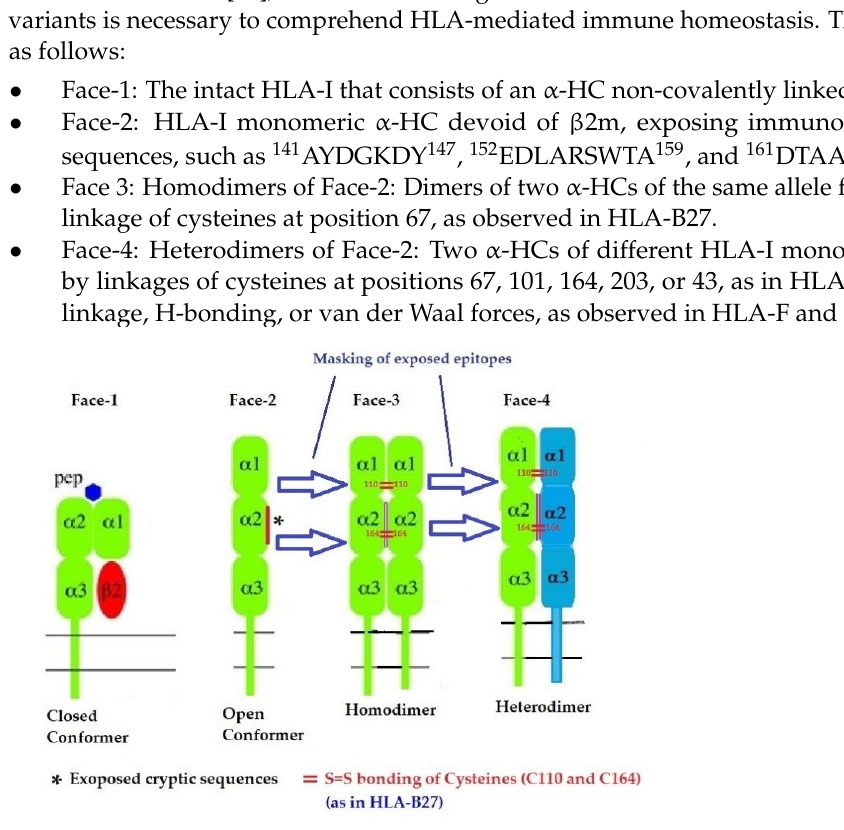
Figure 6. Four major structural configurations or faces of HLA ‐ I. The shared epitopes (see Table 3) remain masked by β 2 ‐ m in Face ‐ 1 or intact HLA. In the absence of β 2m, the HLA becomes mono ‐ meric (Face ‐ 2) on activated immune cells and on cancer cells, resulting in the exposure of cryptic sequences. It appears to be for a shorter duration since the exposed sequence is masked by homodi ‐ merization or heterodimerization. During dimerization, there is an increased propensity for pairing of cysteines and formation of disulfide bonds (as in HLA ‐ B27, HLA ‐ C and HLA ‐ F), a mechanism to remask the exposed